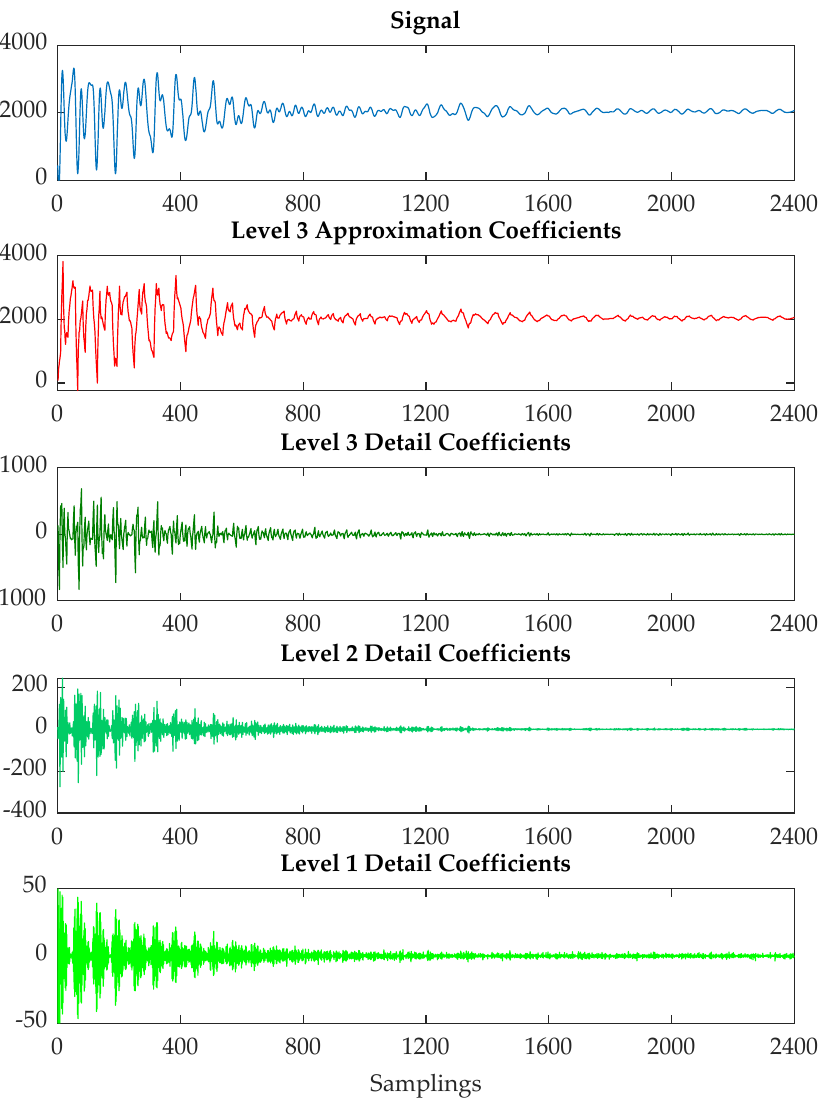
Figure 5. Level 3 full decomposition.